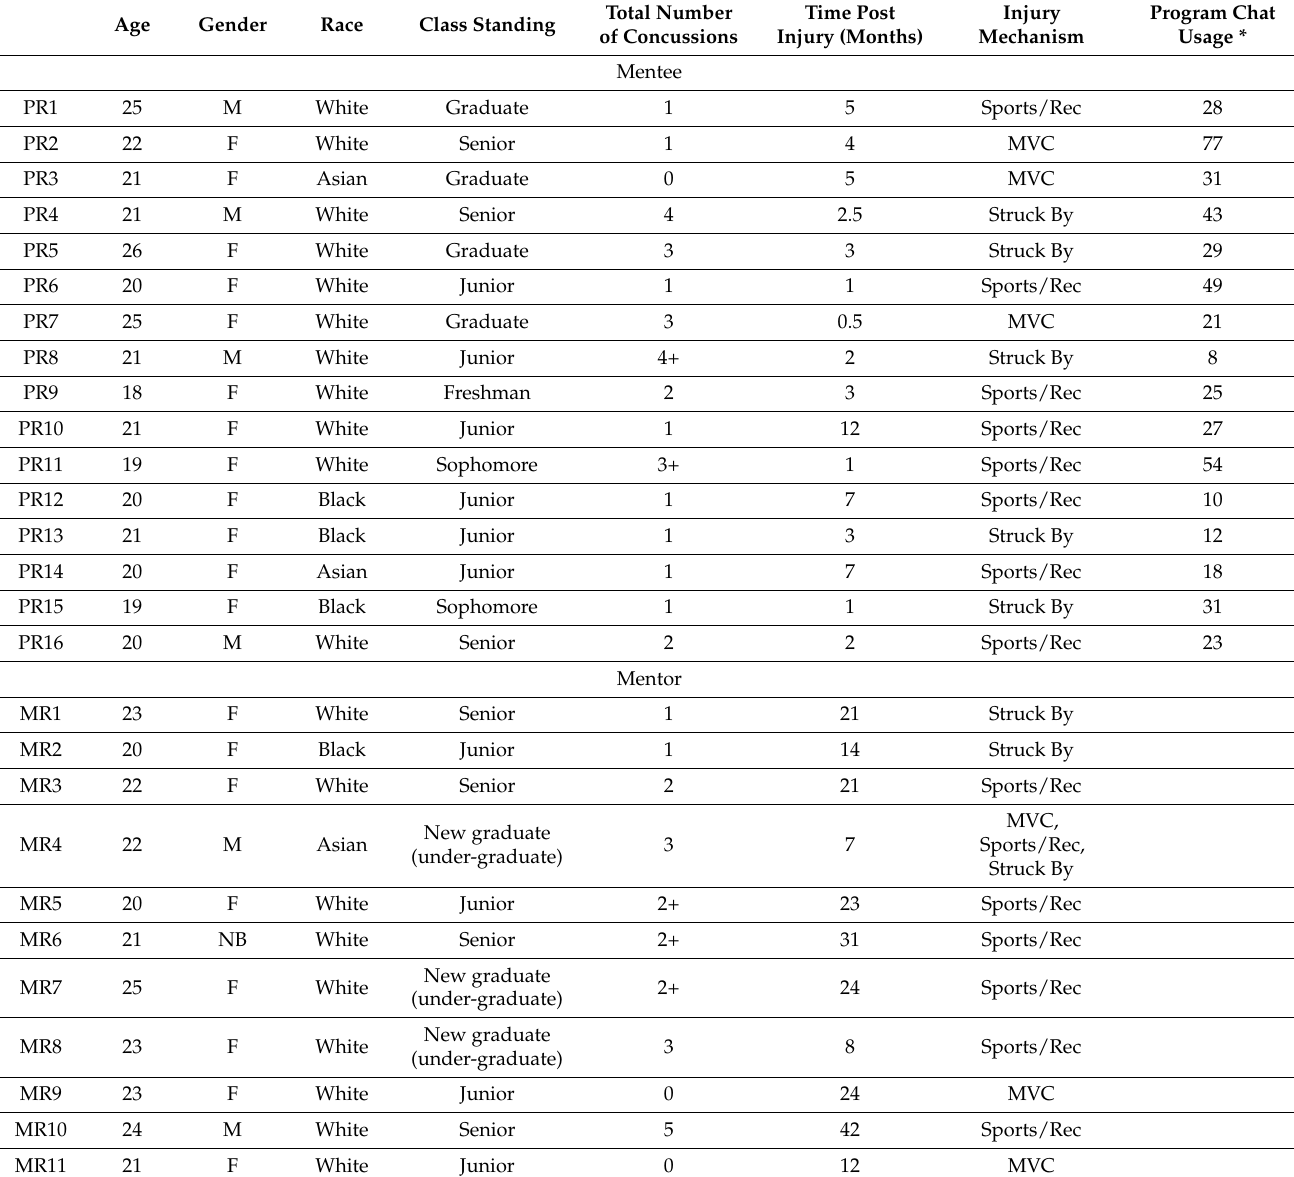
Table 1. Participant